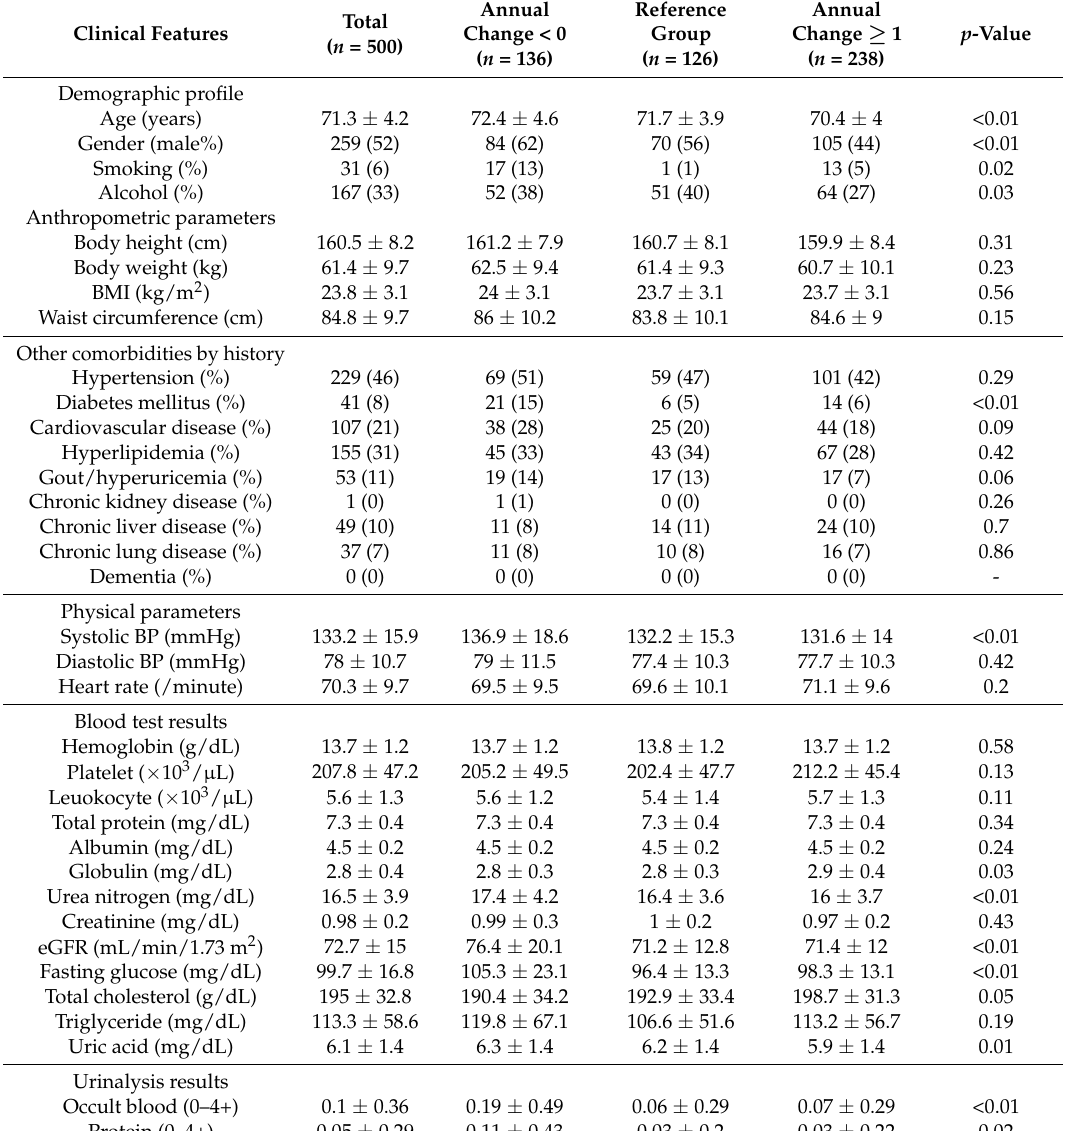
Table 1. Comparison of clinical features between community-dwelling elderly with different trajectories of annual estimated glomerular filtration rate (eGFR) changes (in mL/min/1.73 m 2